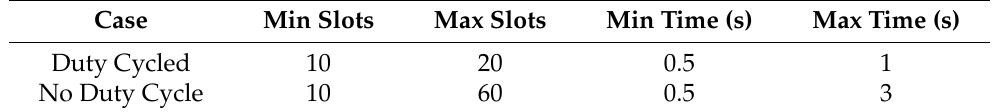
Table 1. Number of slots and seconds for duty-cycled and not duty-cycled